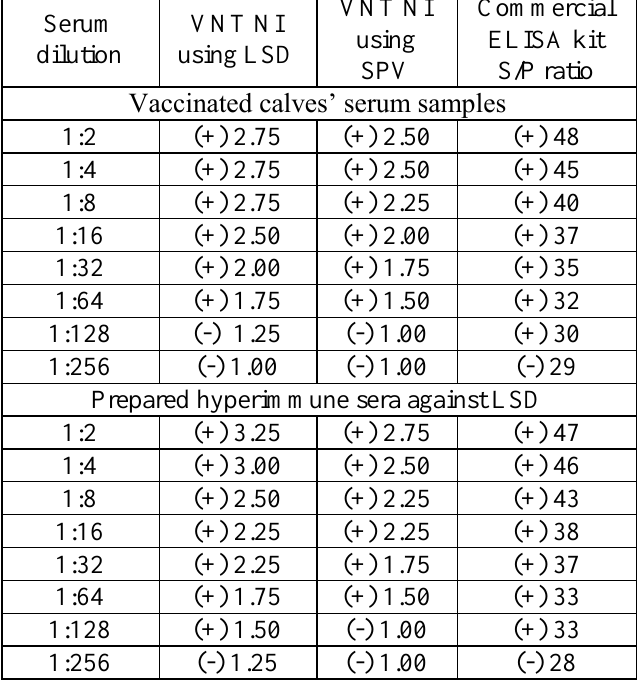
Table 5: Percent of positive and negative